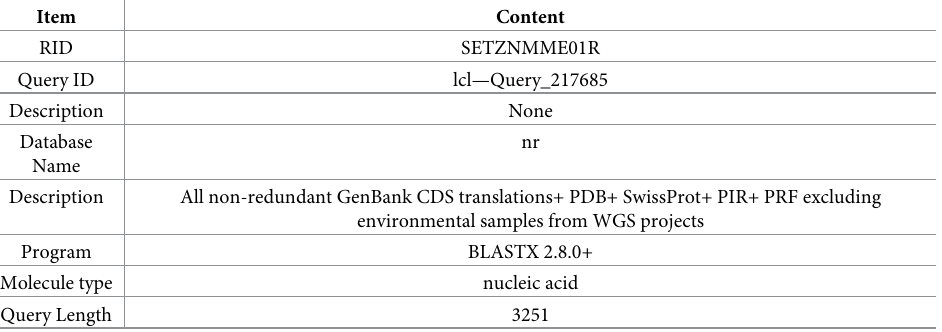
Table 1. The basic information of the comparison result of the suspected gene fragment 21-21000-24250.